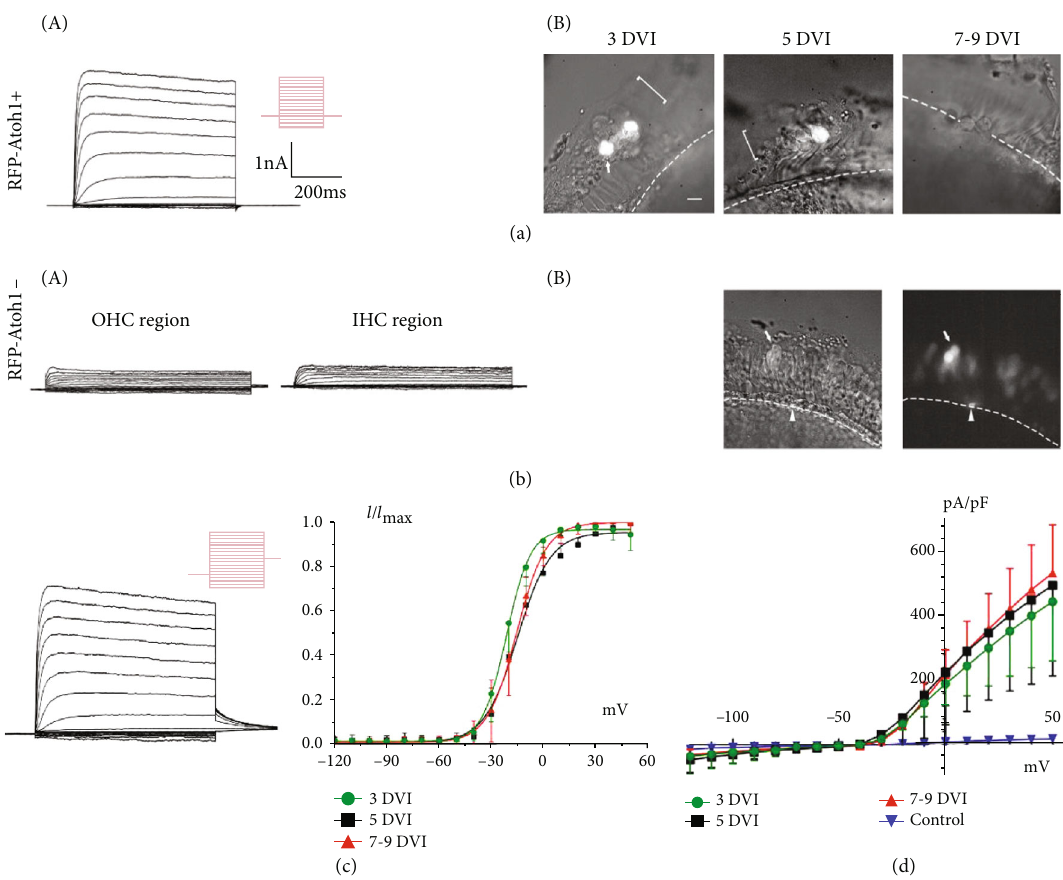
Figure 4: Sustained outward potassium currents of Atoh1-induced HCLCs in adult cochleae. (a) Representative samples of recorded sustained outward K+ currents (A) and micrographs of patched HCLCs (B) obtained from the 3, 5, and 7-9 DVI in the Atoh1+ group. HCLCs are shown in RFP fl uorescence and appear fresher. The voltage protocol is shown beside the traces. The cell clamp was held at a holding potential of -80 mv, and the voltage steps ranged from -120 to 50 mV in 10 mV increments to evoke voltage-dependent currents. (b) Representative outward K+ currents (A) and micrographs (B) of RFP+ cells (nonsensory epithelial cells) from the OHC and IHC regions in the control group. (c) Sustained outward K+ currents with tail currents and voltage-dependent activation curves of HCLCs. (d) I-V curves summarizing the magnitude of outward K+ currents in HCLCs from 3, 5, and 7-9 DVI and the control group, respectively. Scale bar = 20 μ m